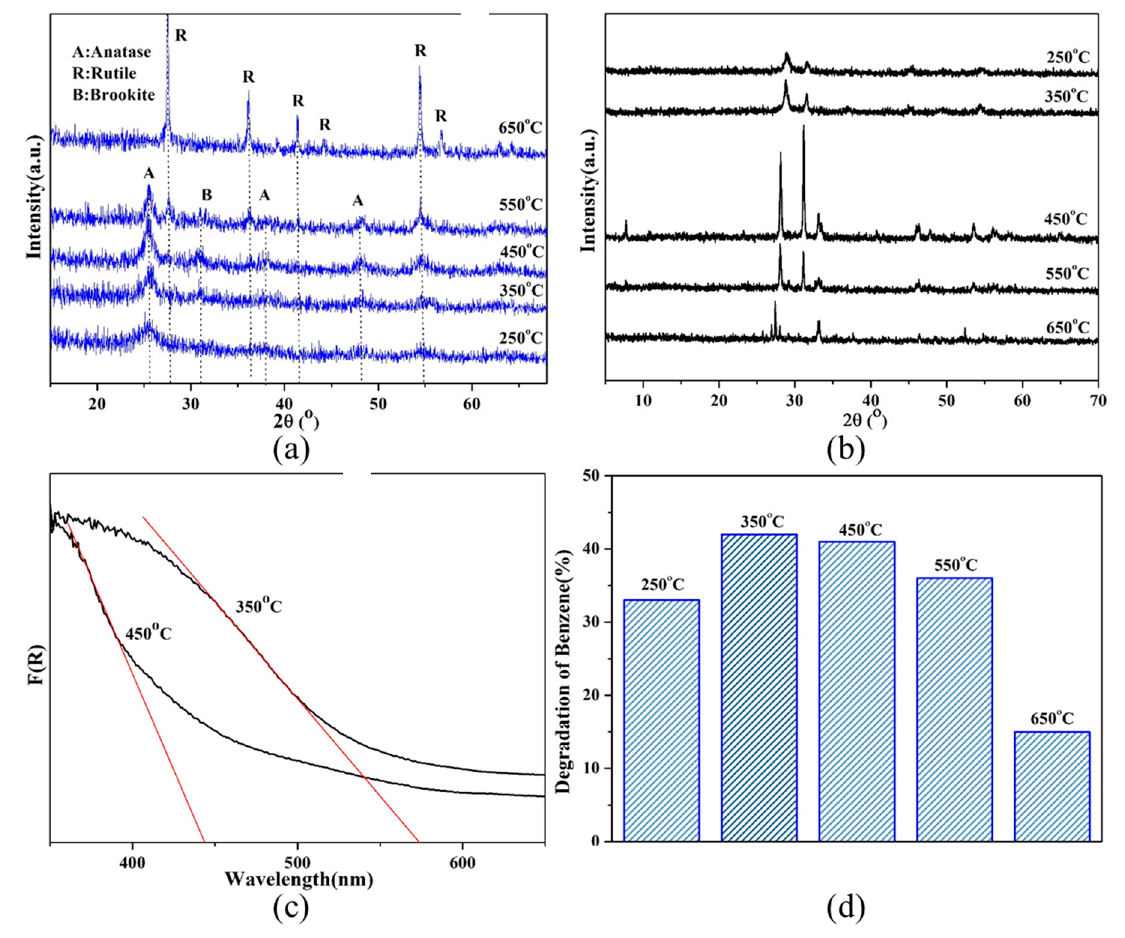
Figure 3. XRD patterns of ( a ) BIT and ( b ) BiOI; ( c ) UV–vis DRS patterns of BiOI; and ( d ) degradation of benzene over BIT calcined at different